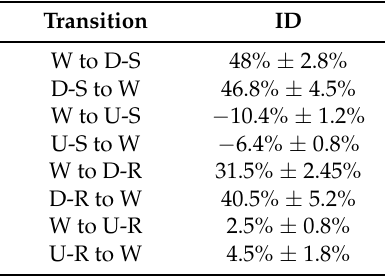
Table 5. DIs of locomotion mode transitions with the proposed